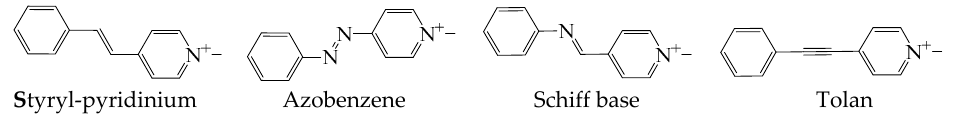
Figure 11. Molecular structures of electron delocalization channels.